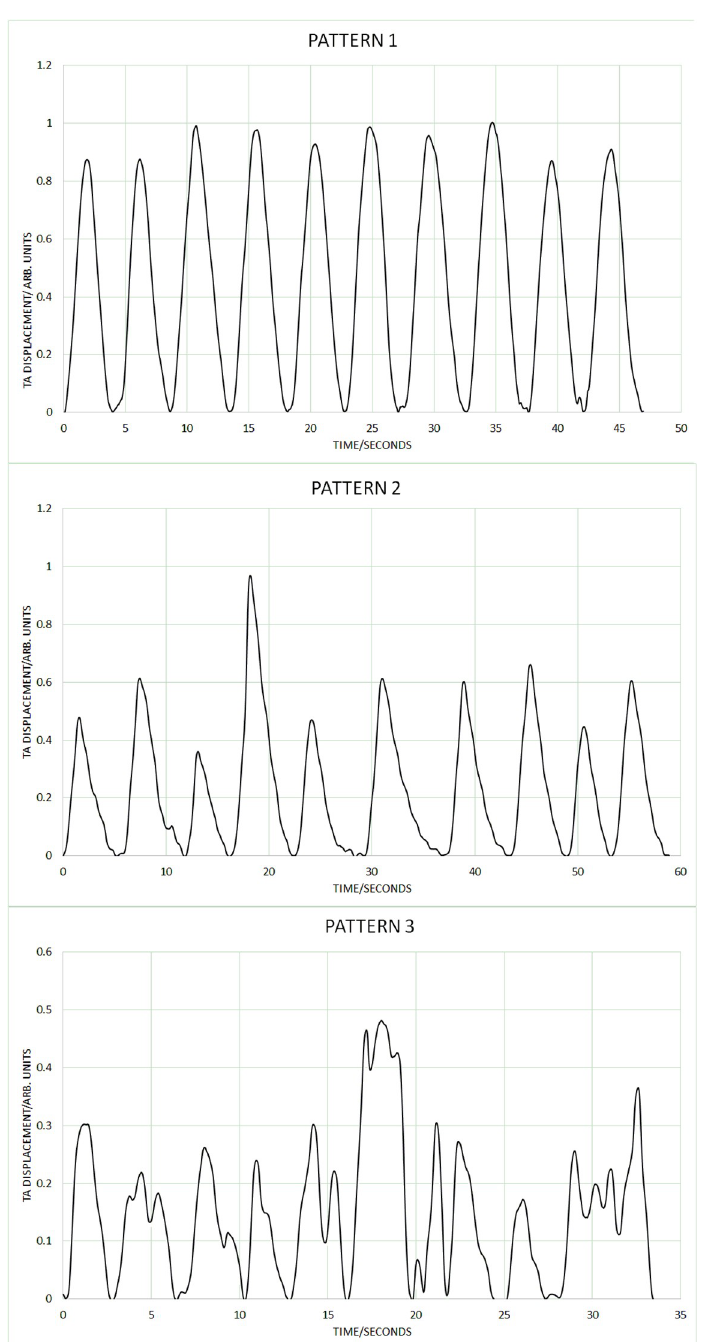
Fig 13. Typical examples of corrected SLP tidal breathing patterns in TA displacement. Pattern 1: regular amplitude and frequency, Pattern 2: regular amplitude and frequency with extended expiratory phase, Pattern 3: irregular amplitude and